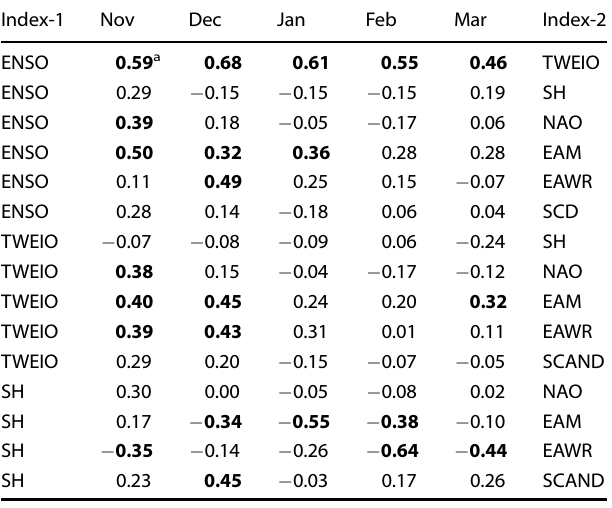
Table 1. Pearson cross-correlations between indices at lag